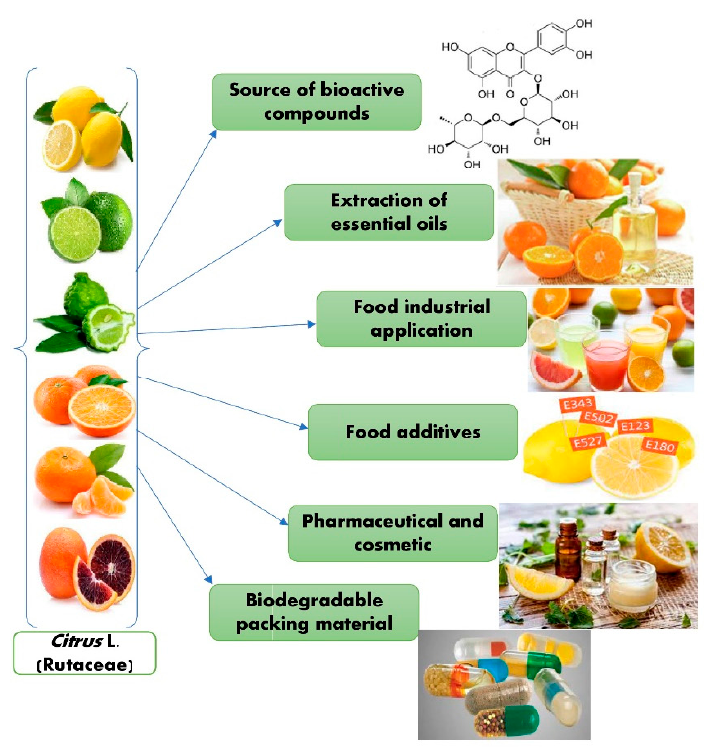
Figure 4. Potential applications of Citrus L.